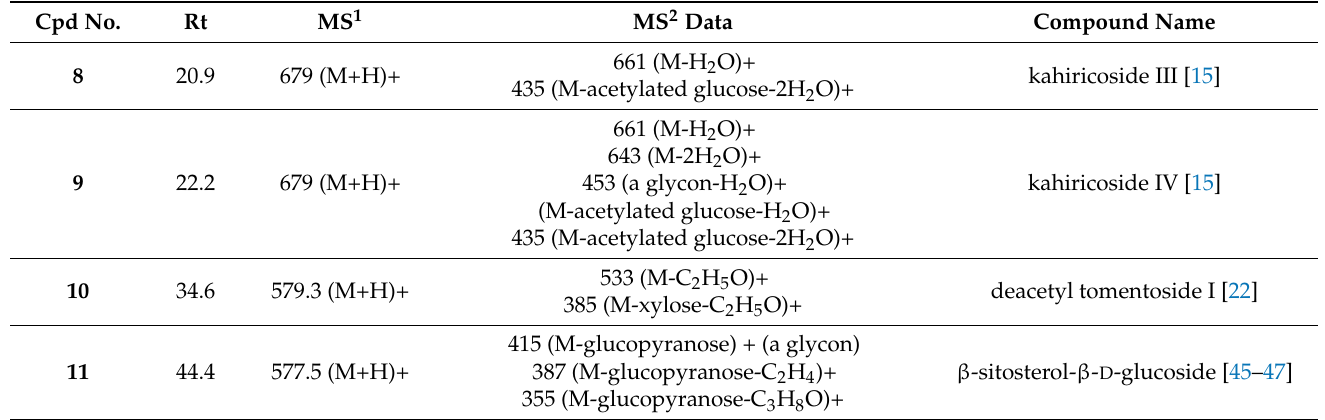
Table 2. Compounds identified in A. fruticosus and their HPLC–MS/MS 2 data using APCI + Ve